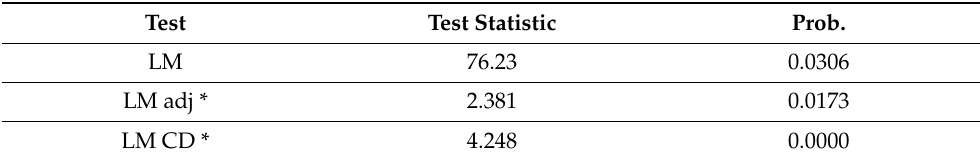
Table 4. Cross-sectional dependence tests’ results.